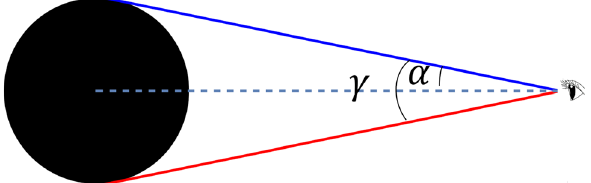
Fig. 1 Schematic diagram for the angles which are related to the angu- lar diameter of the shadow. The angle γ is used in this paper. The angle α is the bending angle in Synge’s work